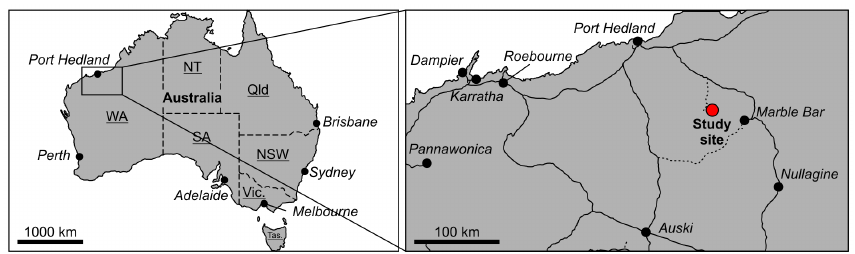
Figure 1. Location of the study site in Western Australia. The hydrothermal chert vein analysed occurs in a recent cut wall of the abandoned Dresser Mine close to Marble